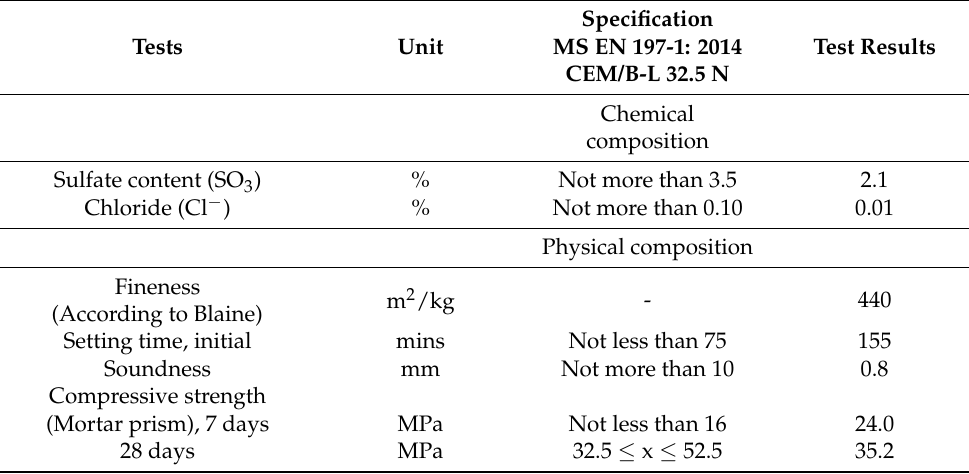
Table 1. Chemical composition and physical properties of ordinary Portland cement (OPC).